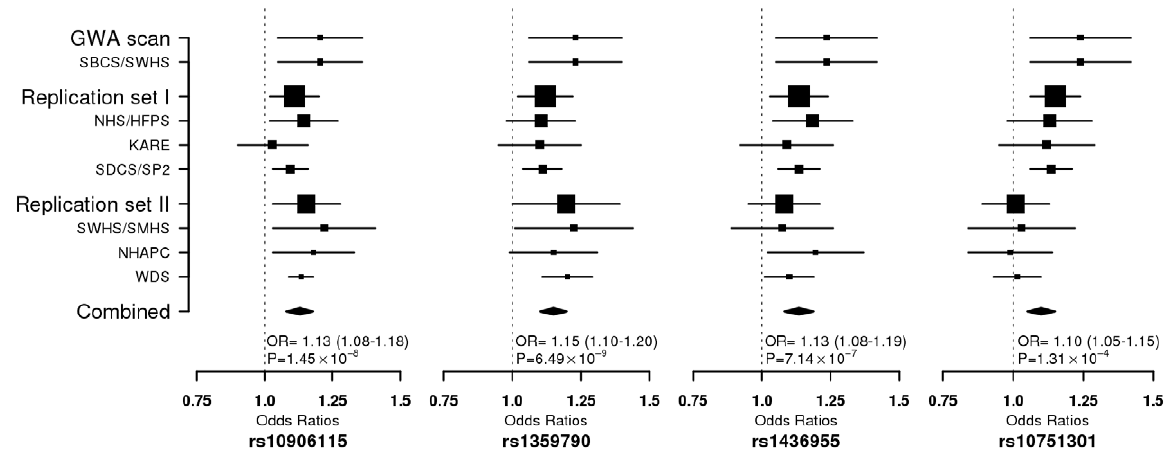
Figure 1. Forest plot for per-allele ORs for the association of T2D risk with 4 SNPs in all participating studies.